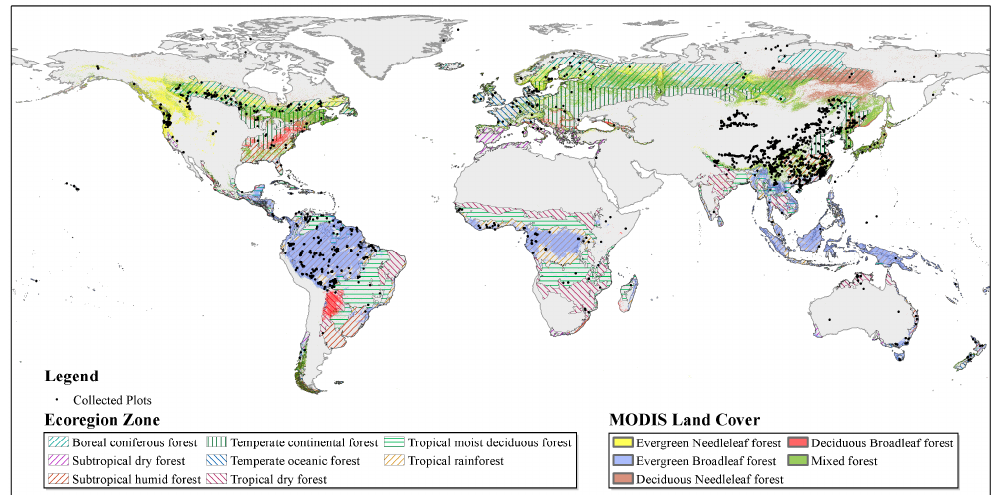
Figure 2. Geolocations of the collected ground inventory data. The background maps are the ecoregion zone map and land cover map from MODIS 2004.